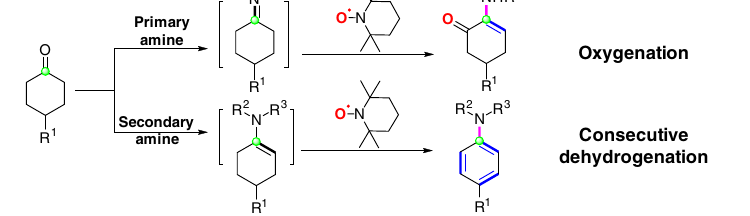
Fig. 1 Similarity and Dissimilarity in Reactivity between Enamine and Tautomerizable Imine. In both nucleophilic addition reaction ( a ) and Pd-catalysed intramolecular α -C-H arylation reaction of α -hydrogen-containing imine ( b ), imines participate in reaction through taotumerization to their enamine tautomers and show similar reactivity to enamine. The reaction of cyclohexanones, amines and TEMPO depends on the reaction intermediates and affords α -amino enones from primary amines and arylamines from secondary amines ( c ), exhibiting the dissimilarity in reactivity between enamine and α -hydrogen-containing